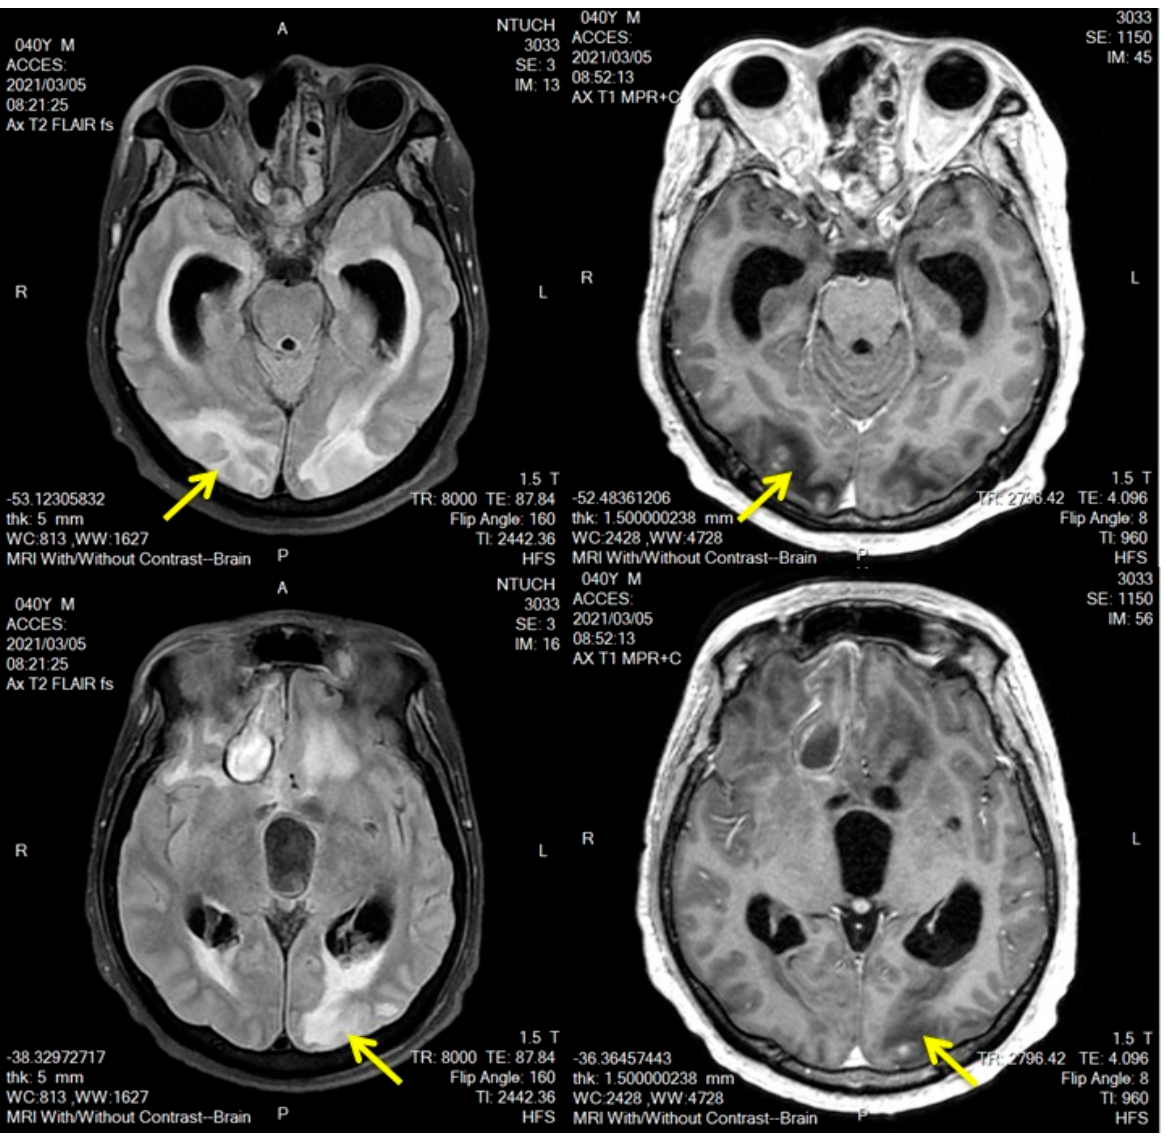
Figure 2. MRI was conducted on 5 March, 2021. The yellow arrow indicates a bilateral occipital cortico-subcortical lesion with low T1-weighted SI, high T2-weighted SI, and faint scattered foci of enhancement.